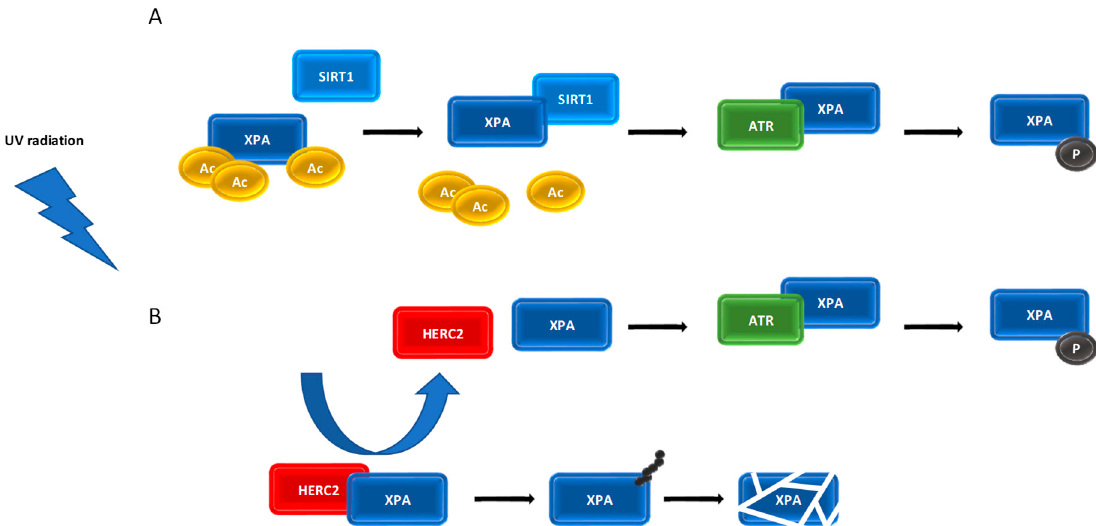
Figure 3. Proposed ATR-SIRT1-XPA and ATR-HERC2-XPA axis. UV-induced DNA damage activates the ATR kinase, which promotes SIRT1 localization at the damage sites and SIRT1-mediated deacetylation of XPA. Deacetylated XPA is a substrate for ATR-mediated phosphorylation. Phosphorylated XPA enhances the repair of damaged DNA ( A ). Upon UV radiation, ATR facilitates the dissociation of the HERC2-XPA complex and prevents XPA ubiquitination and subsequent degradation ( B ).